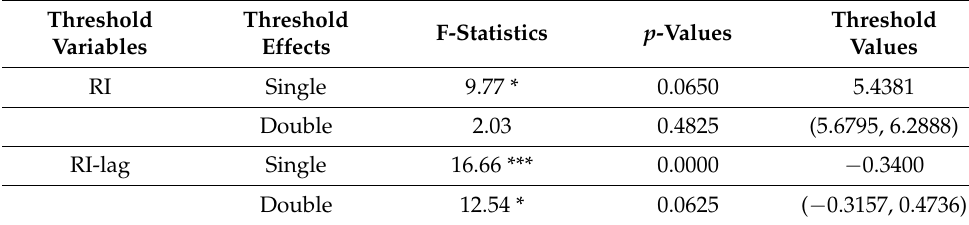
Table 4. Overall threshold effect test in